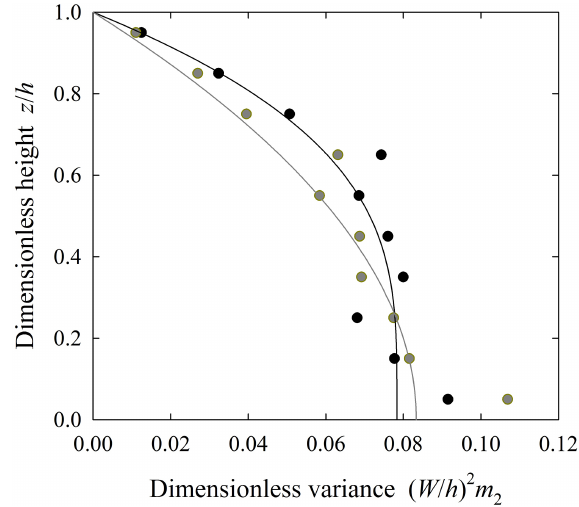
Figure 9. Plot of dimensionless variance ˆ m 2 = ( W/h ) 2 m 2 versus dimensionless height ˆ z = z/h showing values obtained from simu- lations ( Pe = 1) for uniform mixing (black circles) and nonuniform mixing (gray circles) compared with theoretical values (black and gray